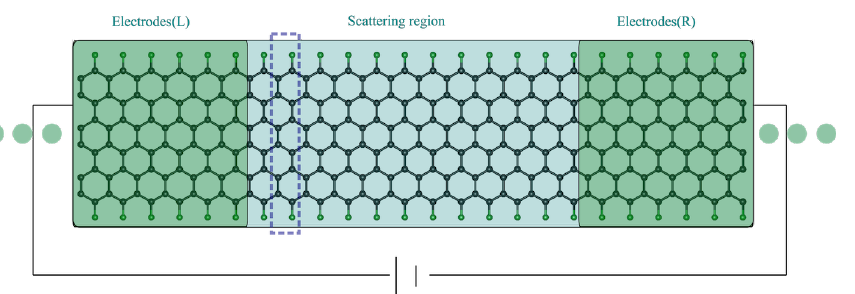
Figure 1. Representation of a transport model based on 6ZGNRs with fluorinated edges. Carbon atoms are drawn in black, the fluorine atoms are in green. One ZGNR unit is marked with dash lines. The nanojunction is partitioned into three parts: the central scattering region (12 units) and two electrodes parts (L/R with 6 units). The Hamiltonians and the overlapping matrices of the complete system are partitioned into three Hamilton matrix blocks: H / S scat , H / S L , and H / S R , respectively. A detailed description of the Hamilton matrix construction procedure can be found in our previous publication [41]. The electrodes part of the transport Hamiltonians, shown in the green boxes, is set with periodic boundary conditions, which satisfies the semi-infinite feature requirement in the partition procedure of the complete Hamiltonian